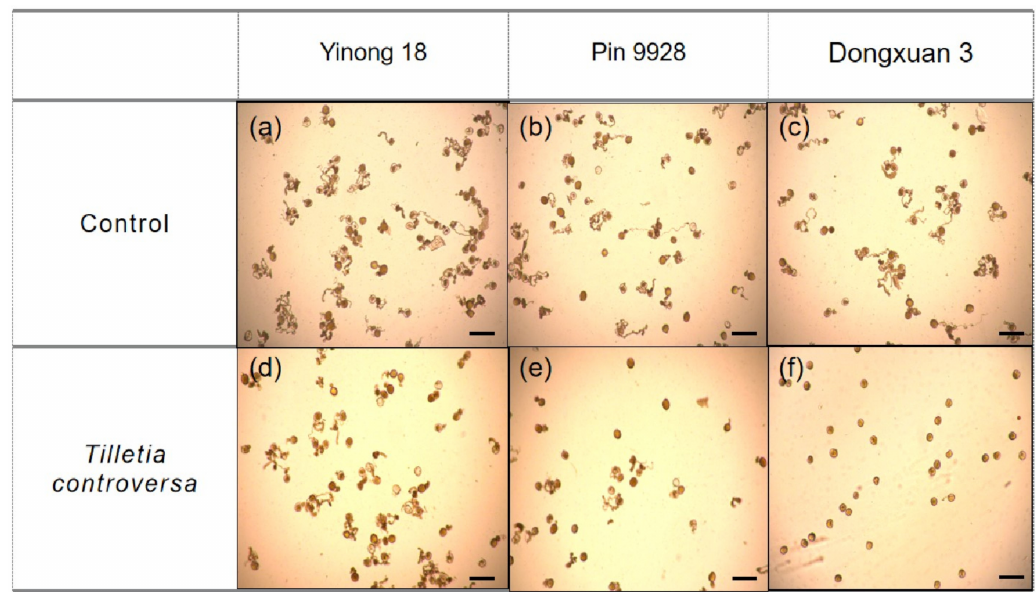
Figure 6. Effect of T. controversa on pollen germination (%). ( a ) pollen germination in control samples of resistant cultivar (Yinong 18); ( b ) pollen germination in control samples of moderately resistant cultivar (Pin 9928); ( c ) pollen germination in control samples of susceptible cultivar (Dongxuan 3); ( d ) pollen germination in T. controversa infected samples of resistant cultivar (Yinong 18); ( e ) pollen germination in T. controversa infected samples of moderately resistant cultivar (Pin 9928); ( f ) pollen germination in T. controversa infected samples of susceptible cultivar (Dongxuan 3) Scale bar = 100 µ m.